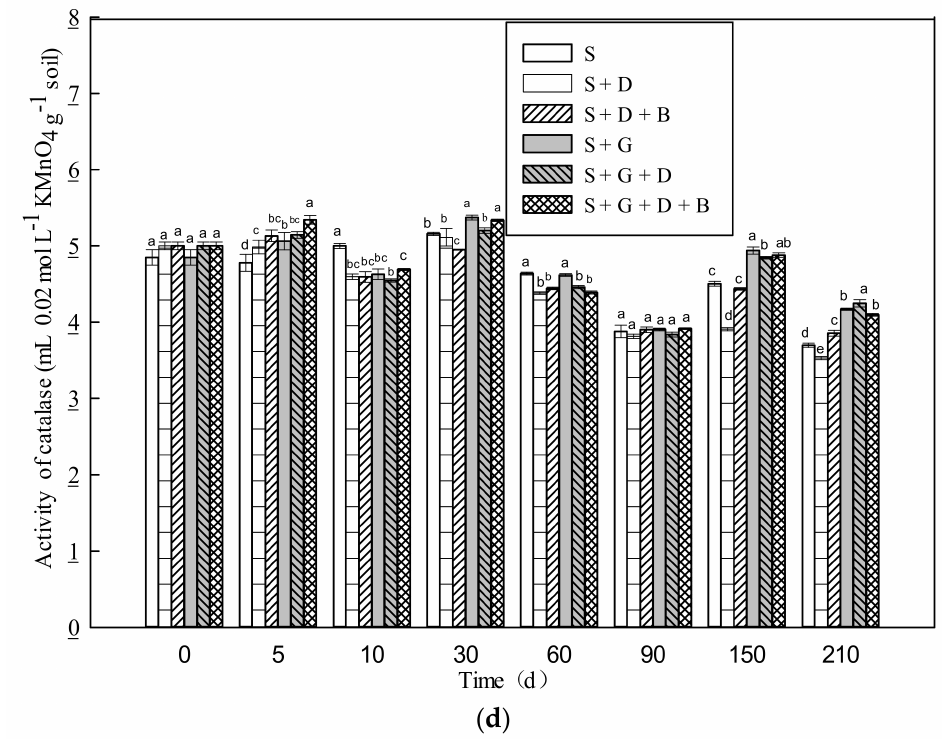
Figure 3. Change of enzyme activity in the soil during the bioremediation process. The error bar indicates the standard deviation; the letters (a, b, c and d) in columns indicate significant differences at p < 0.05 level among 6 treatments at the same times. ( a ) polyphenol oxidase. ( b ) urease activity. ( c ) dehydrogenase. ( d ) catalase